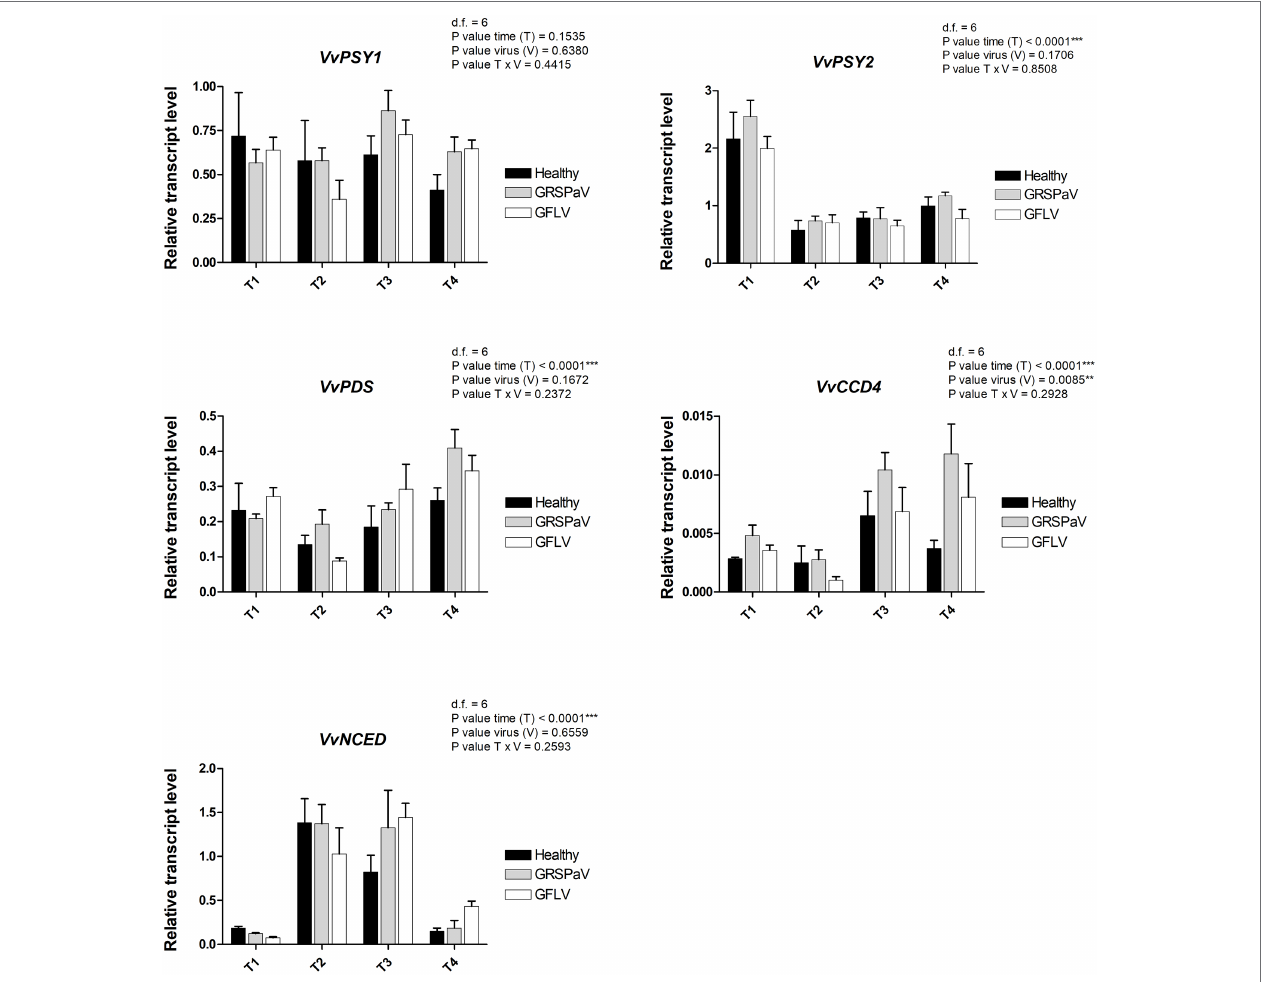
FIGURE 8 | Relative expression levels of VvPSY1 (VIT_04s0079g00680), VvPSY2 (VIT_12s0028g00960), VvPDS (VIT_09s0002g00100), VvCCD4 (VIT_02s0087g00930), and VvNCED (VIT_19s0093g00550), measured by RT-qPCR. Samples were collected in four sampling points along the season (May_T1, June_T2, July_T3, and August_ T4). RT-qPCR signals were normalized to VvAct and VvUBI transcripts. Data are presented as the mean ± SE ( n = 4). Significance of sampling time, virus, and time x virus (T × V) interaction was assessed by Tukey’s HSD test for p ≤ 0.01 (**), p ≤ 0.001 (***) and the corresponding results are given above each graph in the figure